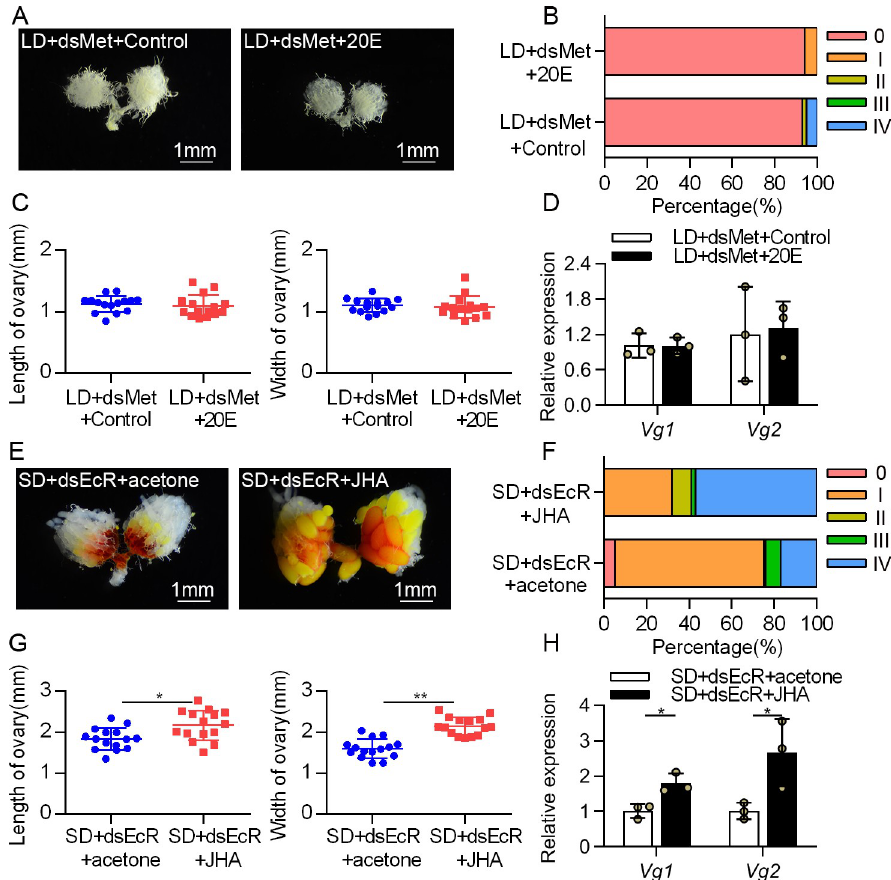
20E-JH signaling. (B) The development grades and (C) sizes of ovaries were analyzed following dual-injection with dsMet and 20E. (D) The expression of Vg1 and Vg2 were detected in the fat bodies after injection with dsMet and 20E. Relative gene expression values represent the fold changes between LD+dsMet+Control and LD+dsMet+20E. (E) Representative phenotypes of ovaries from SD females injected with dsEcR and JHA. (F) The development grades and (G) sizes of ovaries were analyzed after treated with dsEcR and JHA. (H) Relative abundance of Vg1 and Vg2 mRNA in the fat bodies after injection with dsEcR and JHA. Relative gene expression values represent the fold changes between SD+dsEcR+acetone and SD+dsEcR+JHA. Error bars represent the sd. � P < 0.05, �� P <